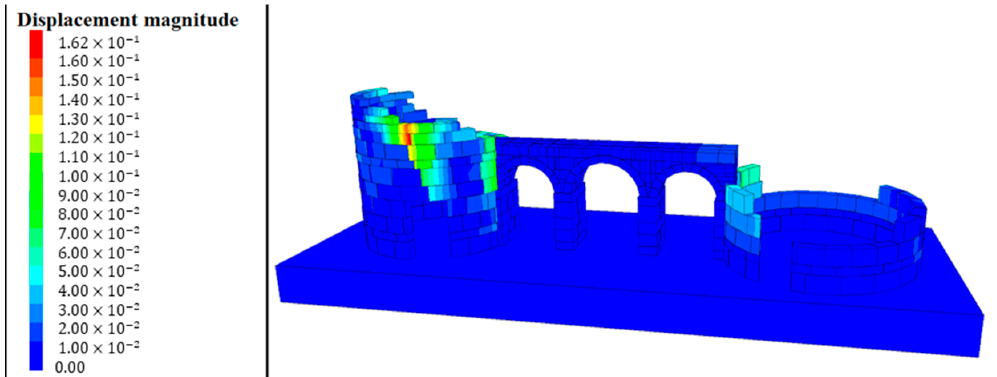
Figure 13. Displacement magnitude for ground motion level 2, under the first case as 100% of the first synthetic earthquake combined with 30% of the second synthetic ground motion .